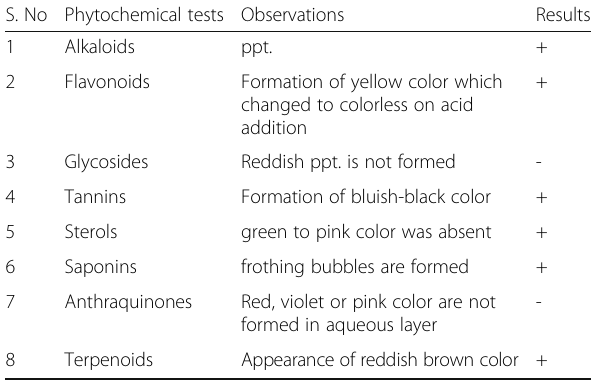
Table 1 Different phytochemical tests for aqueous methanolic extract of Olax nana